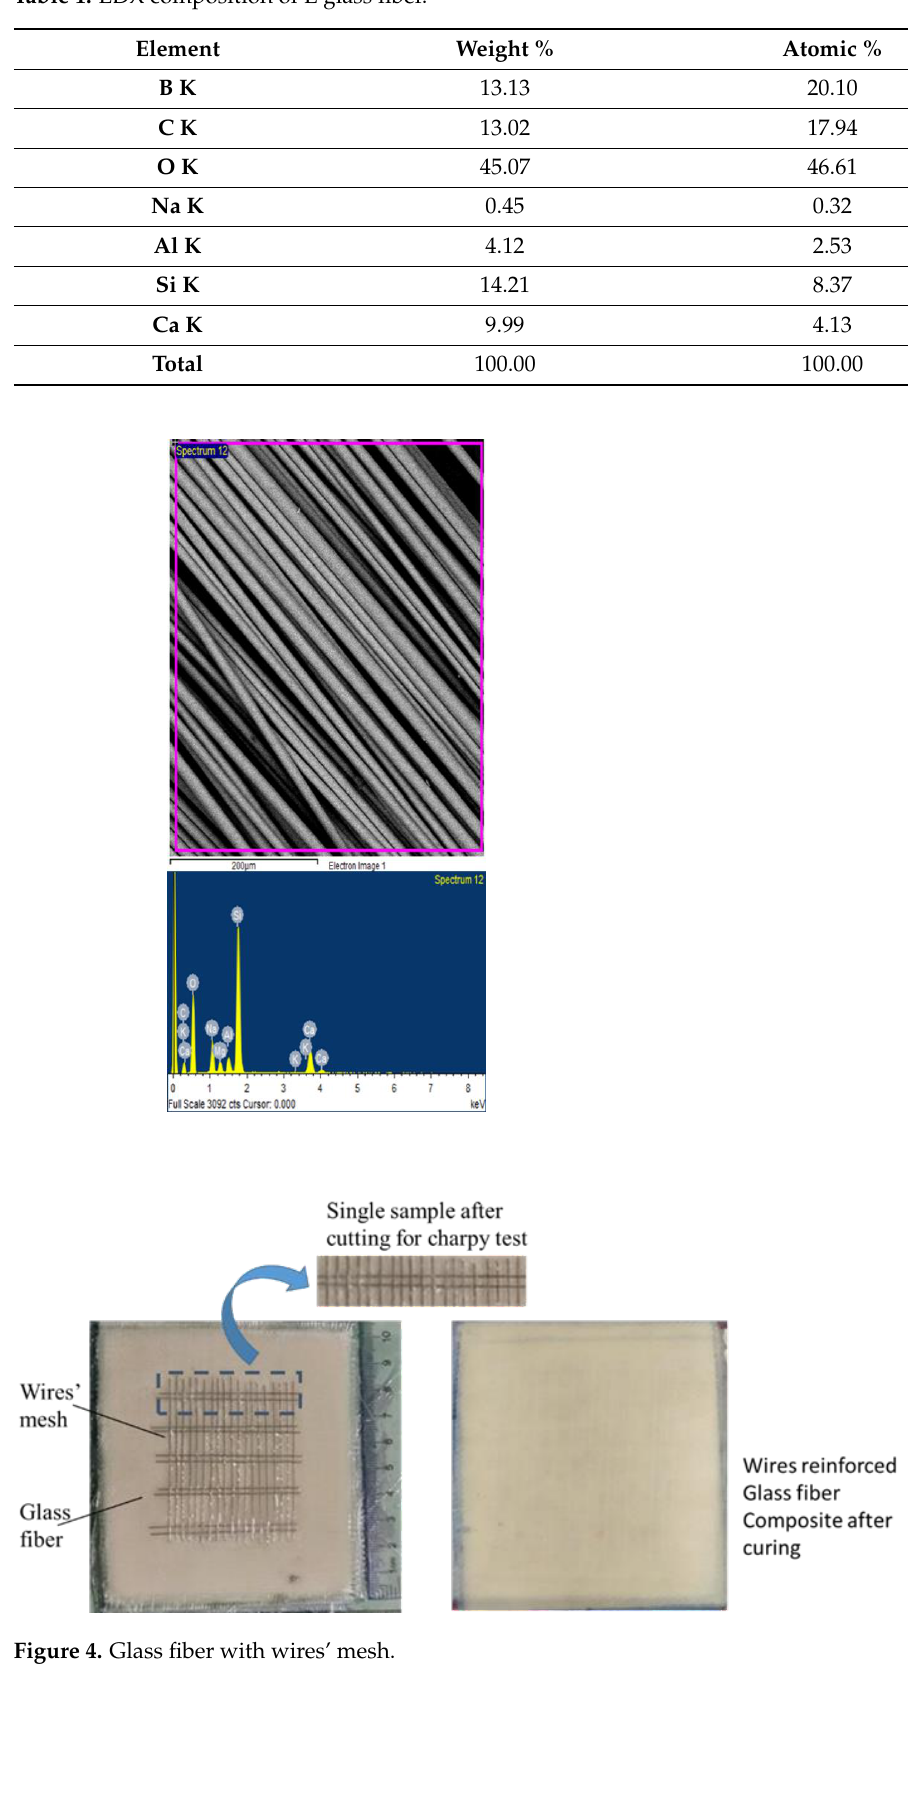
Table 1. EDX composition of E glass fiber.